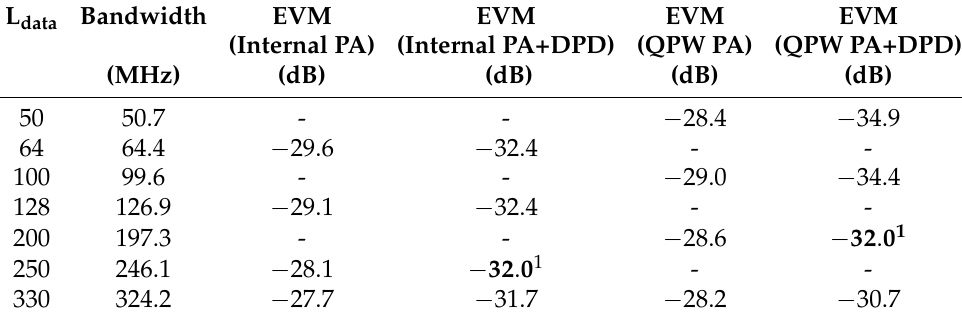
Table 7. EVM with and without digital predistortion for FBMC as a function of the number of data subcarriers L data . The symbol () 1 denotes the EVM fulfilling requirement for 256 QAM and a code rate of